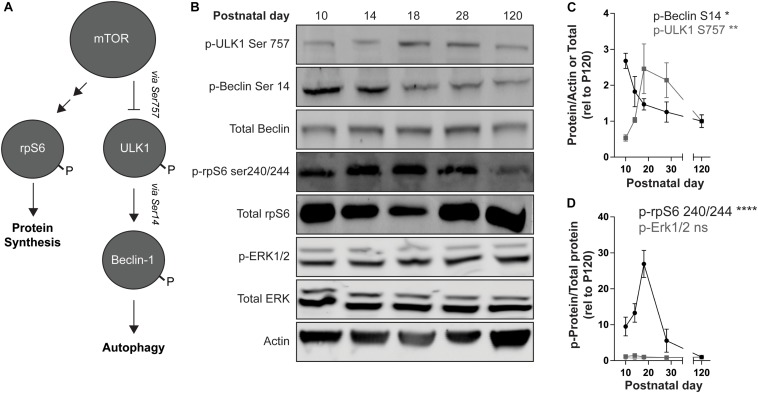
mTOR signaling increases during striatal development. (A) Schematic representation of mTOR targets. mTOR inhibits ULK1 activity by phosphorylating Ser757. P-ULK1 activates Vps34 activity (not shown) by phosphorylating Beclin-1 on Ser14. mTOR promotes protein synthesis by activation of S6K-1 (not shown), which phosphorylates rpS6 on Ser240/244. The single and double arrows indicate direct (i.e., ULK1, Beclin-1) and indirect (i.e., rpS6) downstream targets, respectively. (B) Representative Western blot images quantified in (C,D). (C) Quantification of pULK1 S757 relative to actin (gray squares) and p-Beclin S14 relative to total Beclin-1 (black dots). Data analyzed with one-way ANOVA; p-ULK1 S757/actin: age: F(4,13) = 6.093, p = 0.0055; p-Beclin-1S14/total Beclin-1: age: F(4,14) = 4.945, p = 0.0107. (D) Quantification of p-rpS6 S240/244 and p-Erk1/2 relative to total rpS6 and total Erk1/2, respectively. Data analyzed with one-way ANOVA; p-rpS6 240/244: age: F(4,20) = 12.69, p < 0.0001. p-Erk1: age: F(4,17) = 2.625, p = 0.0712. p-Erk2: age: F(4,17) = 0.3561, p = 0.8362. N = 3–6 mice/age. *p < 0.05, **p < 0.01, ****p < 0.0001.